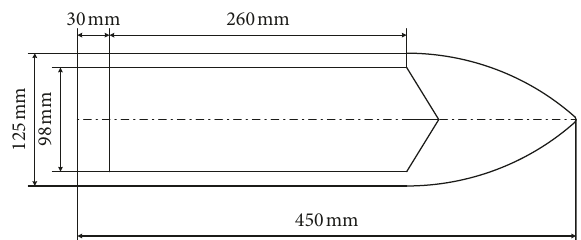
Figure 1: The scheme of the projectile.